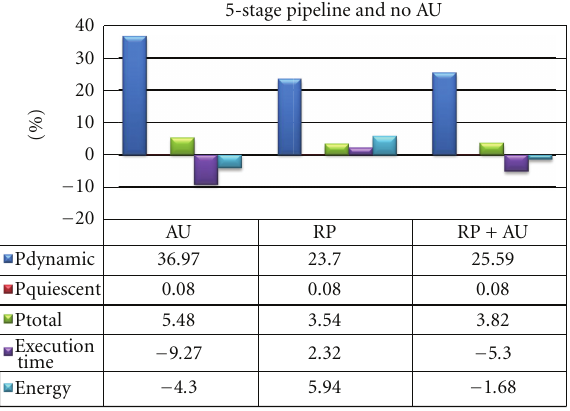
Figure 27: Impact of the MicroBlaze configurations for the Quicksort algorithm.